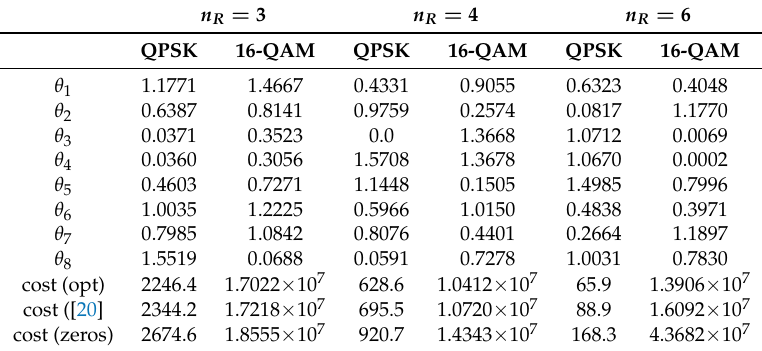
Table 5. Examples of the obtained optimal rotation angles (in radians) for QPSK and 16-QAM and several n R values. The values cost (opt), cost ([20]), and cost (zeros) are the value of the sum in (13) using the obtained optimal rotation angles, the angles given in [20], and the all-zero angles,